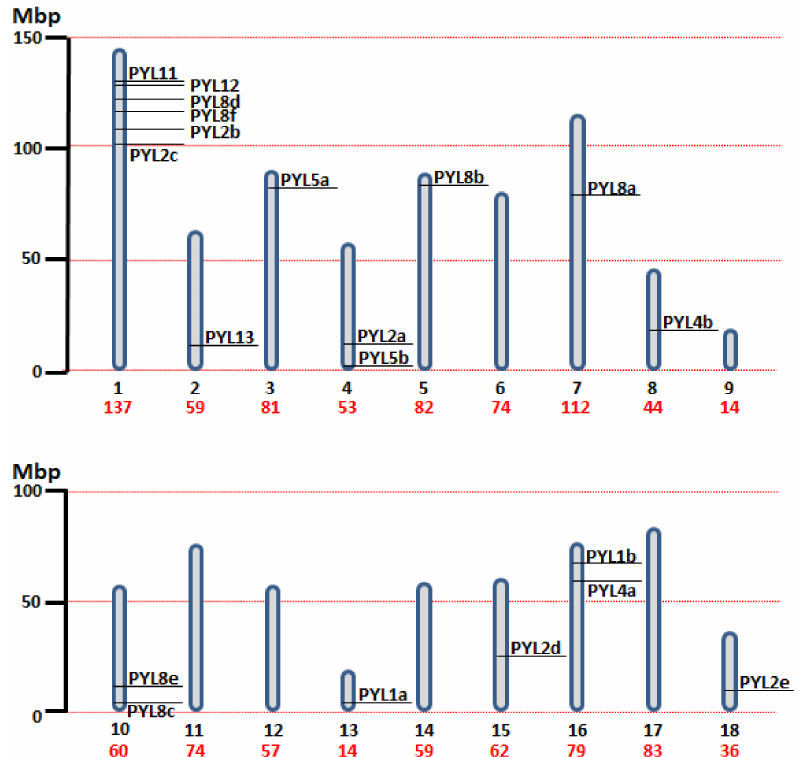
Figure 1. Chromosomal distribution of the identified 20 CqPYL genes across the quinoa genome. The 18 chromosome of quinoa are shown to scale based on their physical size. Mbp: Mega base pair. Under each chromosome in black the chromosome number and in red the chromosome